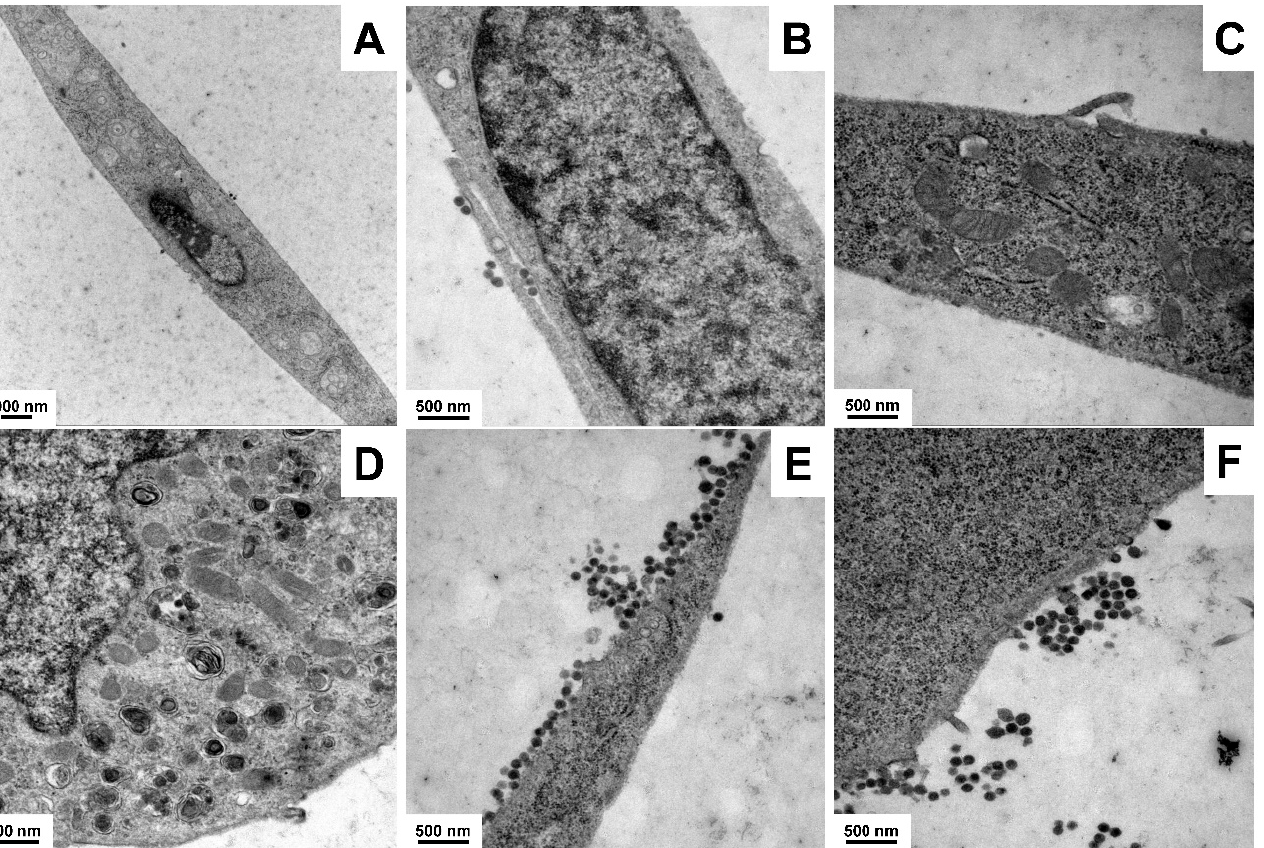
Figure 3. Representative electron microscopic analysis of GRX cells. Typical ultrastructural features of GRX cells are depicted including ( A ) overview of cell structure, ( B ) dense nucleus, ( C ) mitochondria and intracellular fat droplets, ( D ) intracellular retroviruses, and ( E , F ) retroviral particles at cell border. Magnifications: ( A ) 6,000×, ( B – F ) 21,560×.